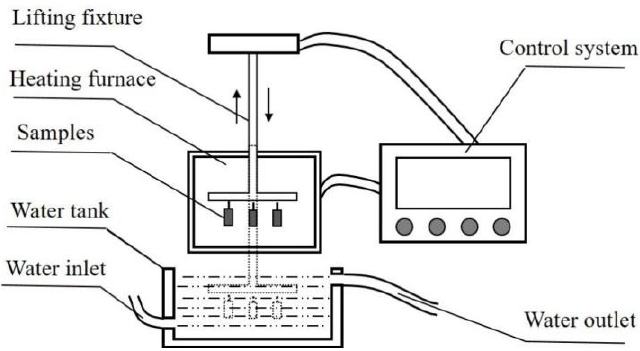
Figure 4. Schematic diagram of thermal fatigue testing apparatus. Table 2. Parameters of the thermal fatigue test.